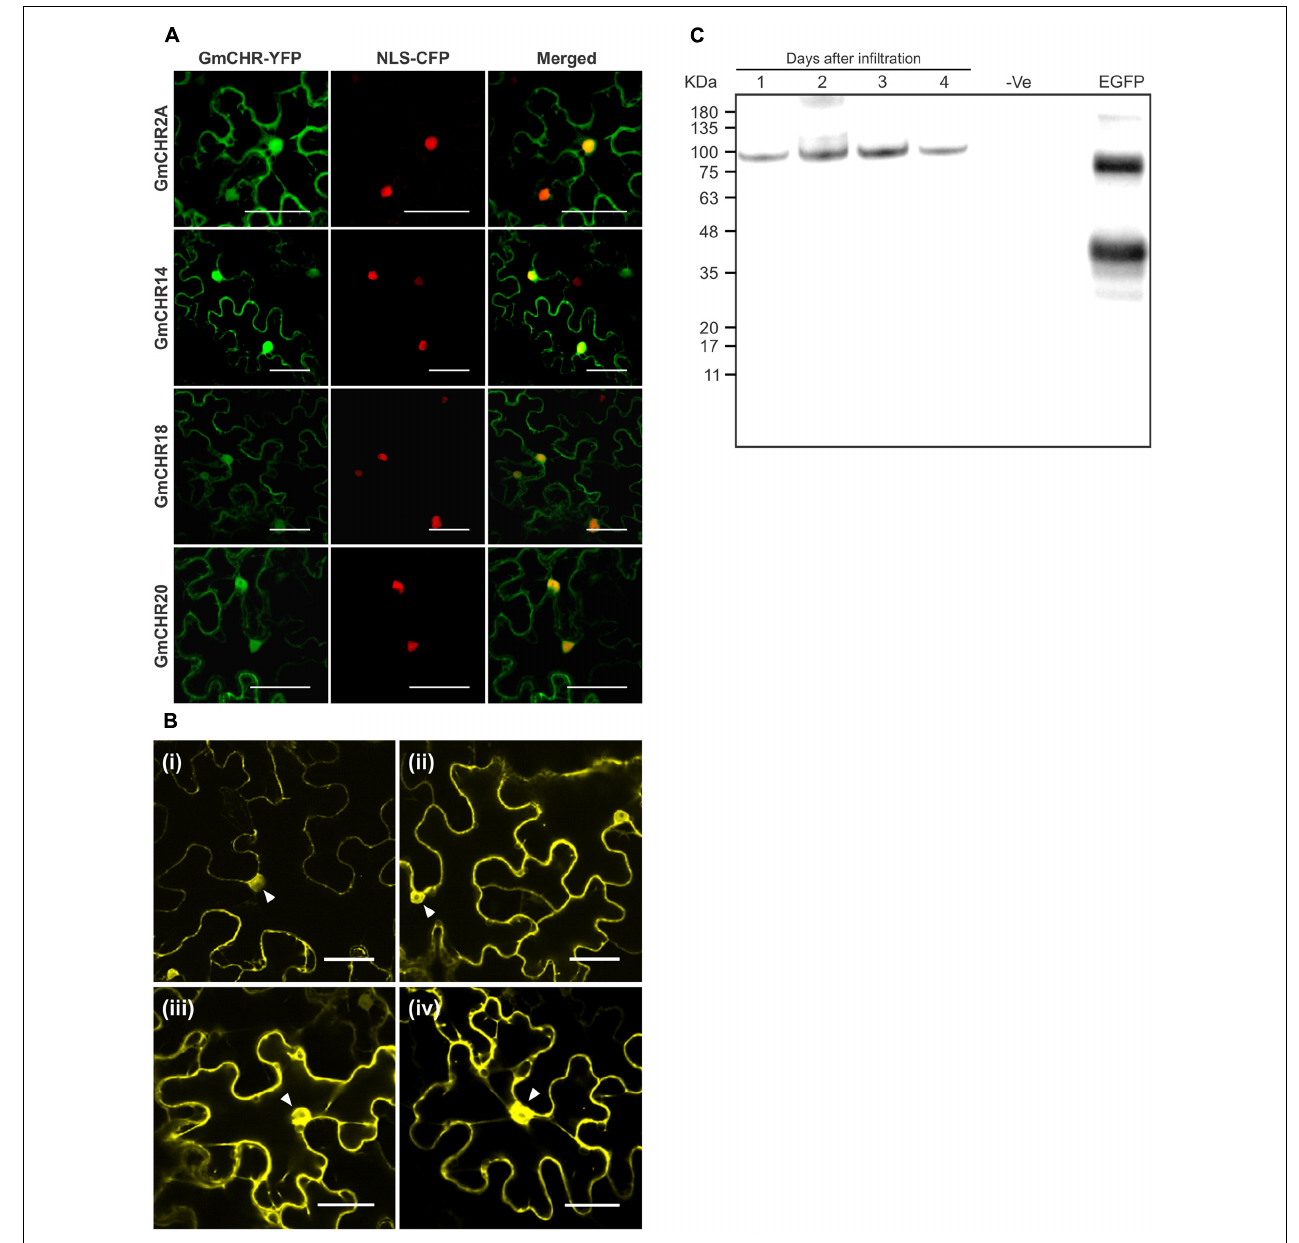
FIGURE 6 | Subcellular localization of stress induced GmCHRs. (A) Four root-specific GmCHR s that show induced expression upon P. sojae infection were translationally fused with the YFP, and transiently expressed in N. benthamiana leaves by A. tumefaciens -mediated transformation followed by confocal microscopy. A nuclear localization signal fused with the CFP (NLS-CFP) was used to confirm nuclear localization. The scale bar indicates 50 µ m. (B) Transient expression of GmCHR2A-YFP-YFP, in the epidermal cells of N. benthamiana as described in (A) . Pictures were taken as indicated (i) Day 1, (ii) Day 2, (iii) Day 3 and (iv) Day 4 post-infiltration. Triangles indicate the nucleus. (C) Western blot analysis of transiently expressed GmCHR2A-YFP-YFP in N. benthamiana leaves. Total proteins were separate on SDS-PAGE and transferred into a PVDF membrane, followed by Western blot analysis. The blot was incubated with anti-GFP primary antibody (1:7000 dilution) and HRP conjugated goat anti-mouse secondary antibody (1:5000 dilution), followed by chemiluminescence detection. Proteins extracted from an uninfiltrated N. benthamiana leaf sample was used as a negative control (–ve), and eGFP with hydrophobin was used as a positive control ( ∼ 37